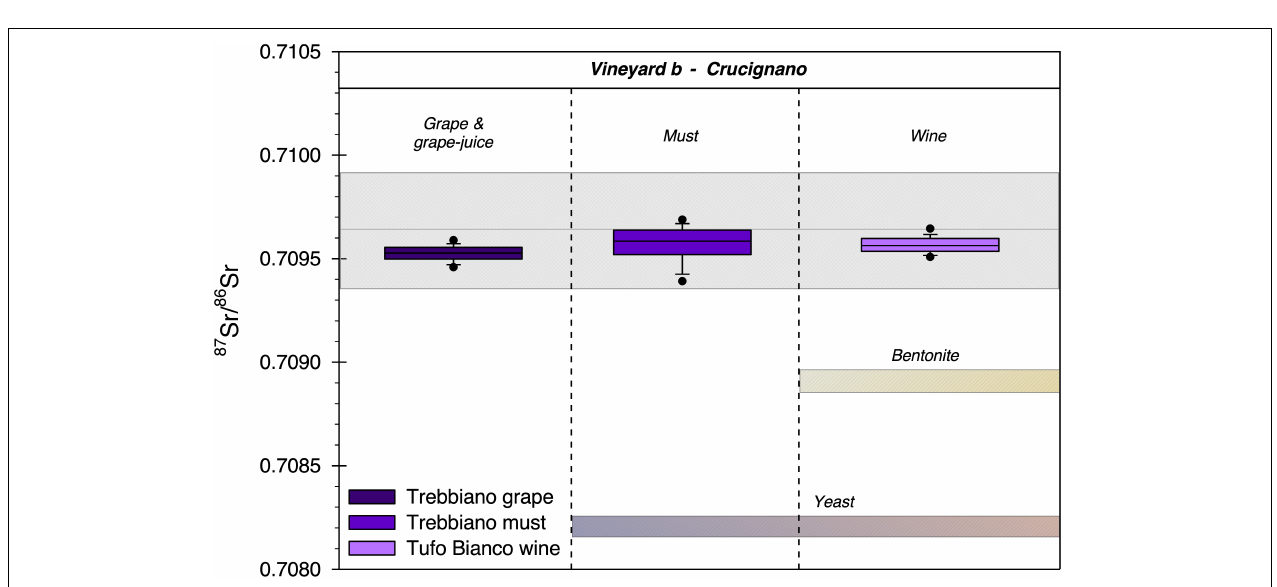
FIGURE 4 | 87 Sr/ 86 Sr values in grape, juice, musts, and wine for the Greco wine (from the 2011 vintage year). Greco is high-quality single-variety wine, composedby Greco alone, which is growth in the area of Pian de’ Conati (vineyard a ). The box plot features are reported through text and in the caption of Figure 2 . The gray pattern represents the whole range of variability of the soil bioavailable fraction, the solid line represents the mean value. The shaded bars represent the isotopic range of the analyzed additives, bentonite, and yeast, respectively. The length of the bars depends on the wine-making step in which such additives are introduced, thus the different matrix in which we investigated their potential effect.